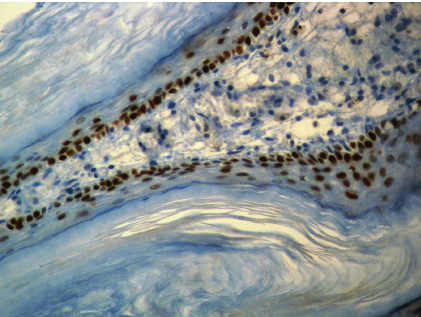
Figure 2: A papillary, exophytic, noninvasive tumor with extensive keratinization on its surface was seen on microscopy (H&E, × 100).